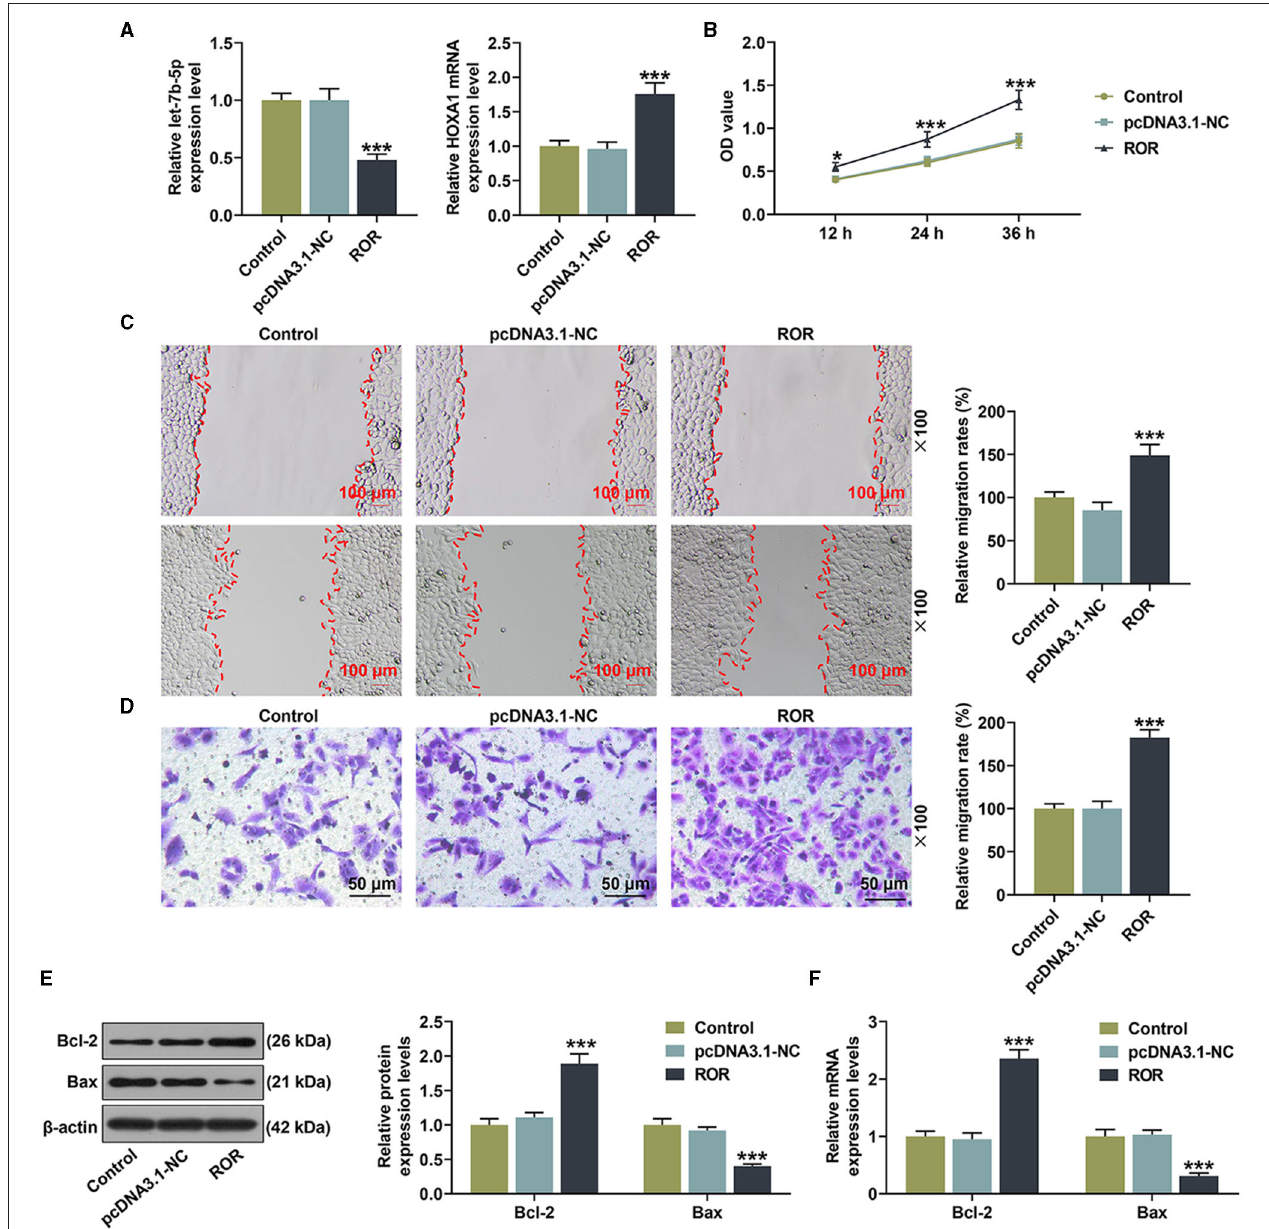
FIGURE 8 | The roles and functions of lncRNA ROR on the viability, migration, and apoptosis-related protein expressions of human umbilical vein endothelial cells (HUVECs). (A) The mRNA expressions of let-7b-5p and HOXA1 were detected after the HUVECs were transfected with lncRNA ROR. (B) The viability was detected after the HUVECs were transfected with lncRNA ROR. (C,D) The migration was detected after the HUVECs were transfected with lncRNA ROR. (E,F) The relative protein/ β -actin expressions of Bcl-2 and Bax were measured by Western blot. β -Actin was used as an internal control. *** P < 0.001 vs .